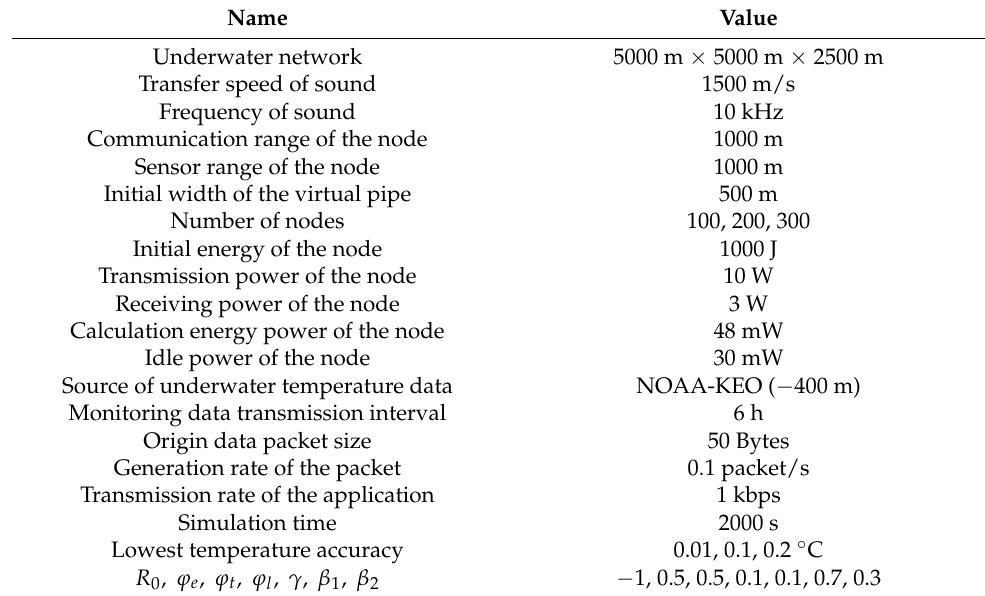
Table 2. Experiment